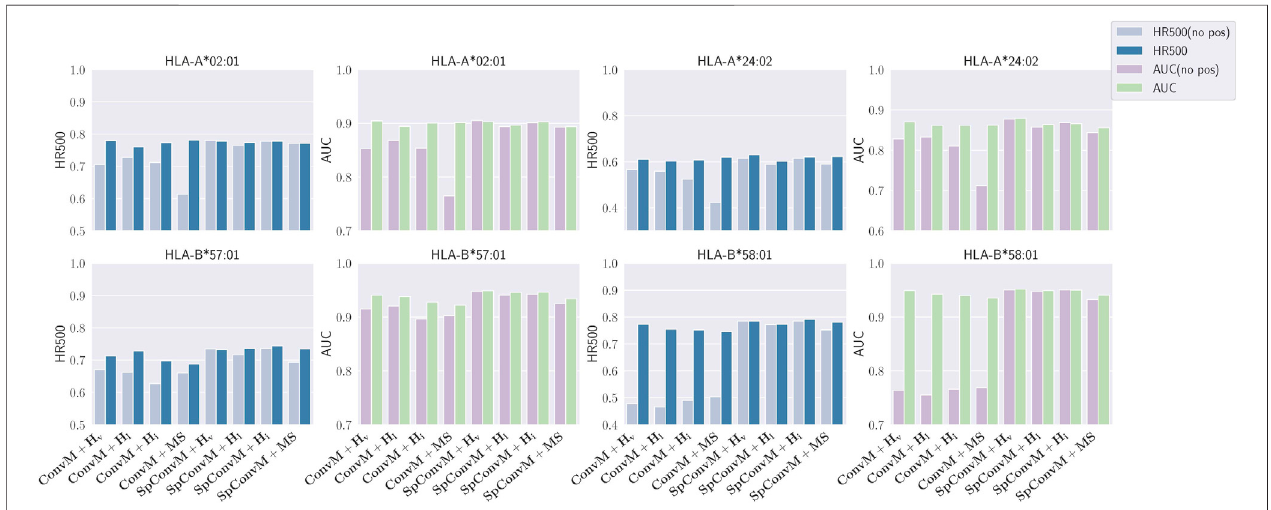
FIGURE 6 | Performance comparison on ConvM and SpConvM with and without position encoding.